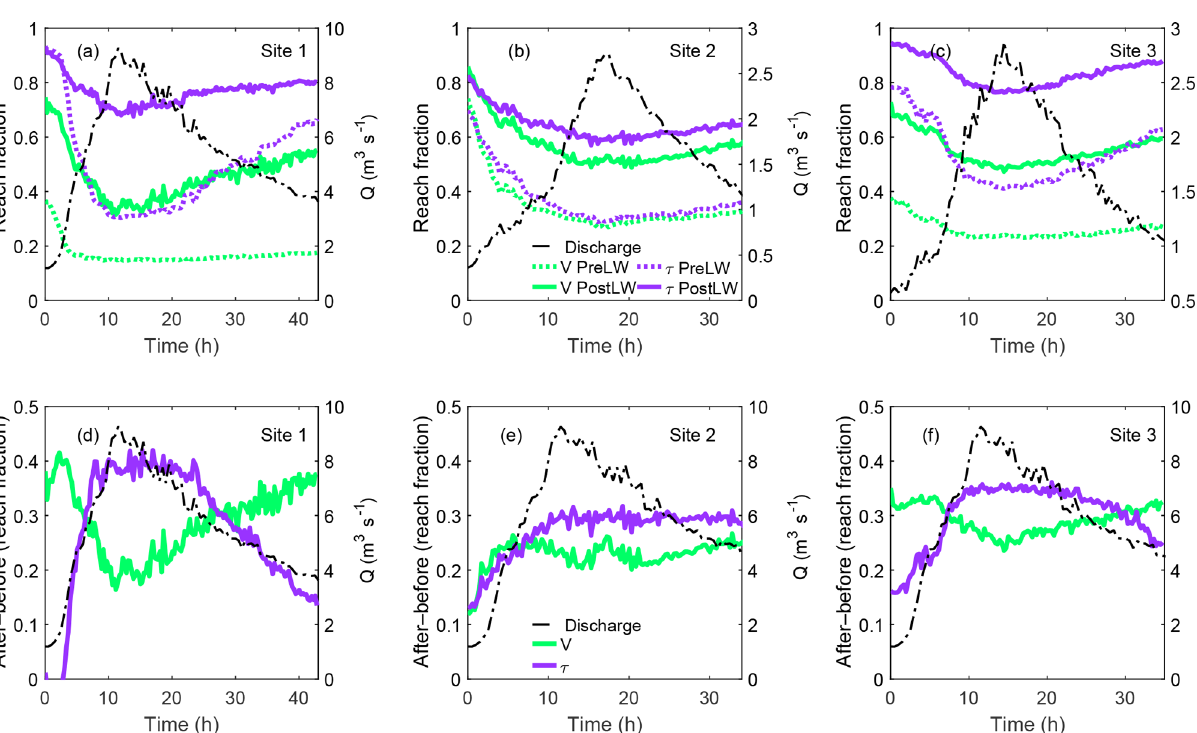
) and shear stress ( τ<τ b c ) expressed as the range of the crit